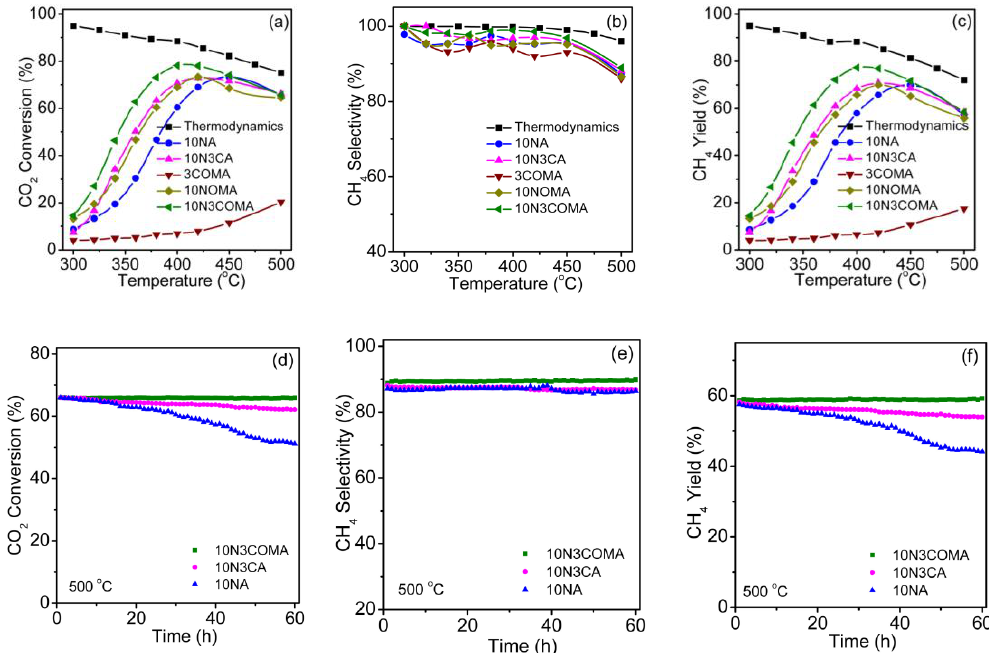
Figure 7. Catalytic properties of the catalysts: ( a , d ) CO 2 conversion, ( b , e ) CH 4 selectivity, and ( c , f ) CH 4 yield. Reproduced with permission from [37]. Copyright: Elsevier, Amsterdam, The Netherlands,